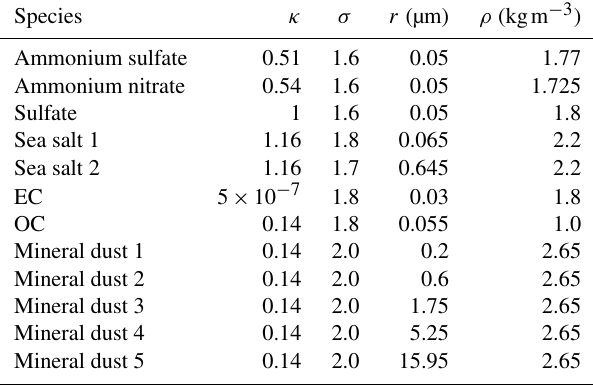
Table 1. Physical and chemical aerosol properties used in this study. The values for the particle radius and standard deviation of the size distribution follow Poulain et al. (2011), Spindler et al. (2012) (non- dust species), and Heinold et al. (2011) (mineral dust). Several labo- ratory and model studies served as the basis for the κ values used in this study (ammonium sulfate: Ghan et al., 2001, Petters and Krei- denweis, 2007; ammonium nitrate: Duplissy et al., 2011; sulfate: Petters and Kreidenweis, 2007; OC: Ghan et al., 2001, Wex et al., 2009; sea salt, dust, and EC: Ghan et al., 2001). Species κ σ